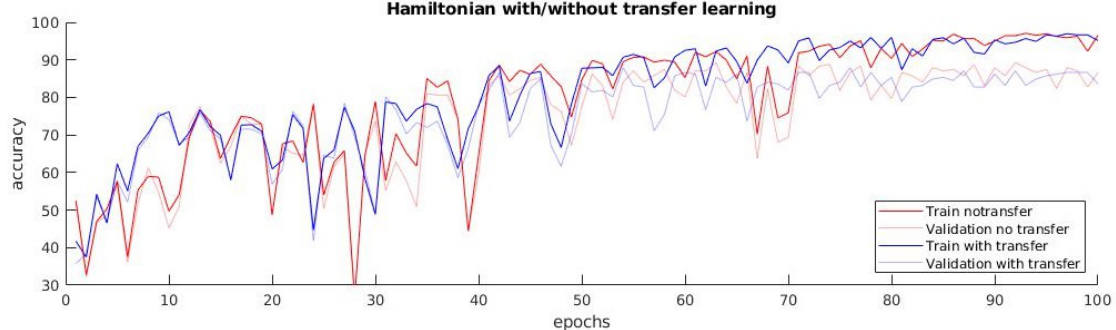
( c ) Comparison between learning curves for training with/without transfer ( Exp 2 and Exp 3 ). Figure 5. Confusion matrix and learning curve for the Hamiltonian networks trained in Experiment 2 and Experiment